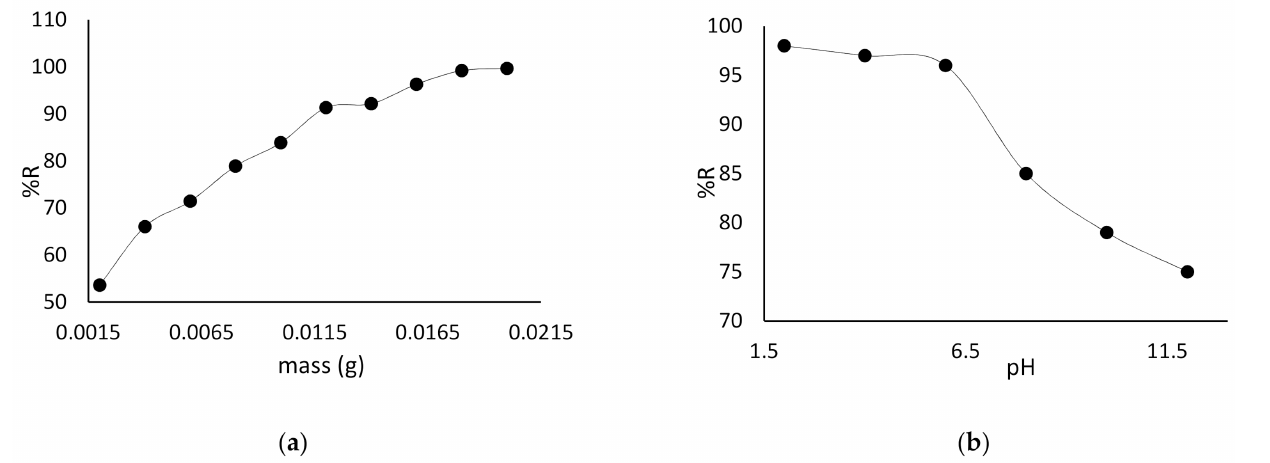
Figure 6. Effects on AO-8 removal efficiency by ( a ) adsorbent dosage. ( b )